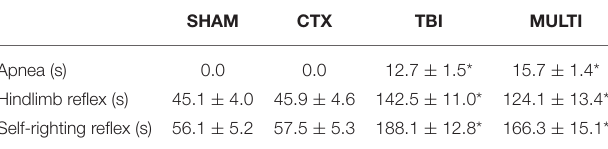
TABLE 1 | Acute injury